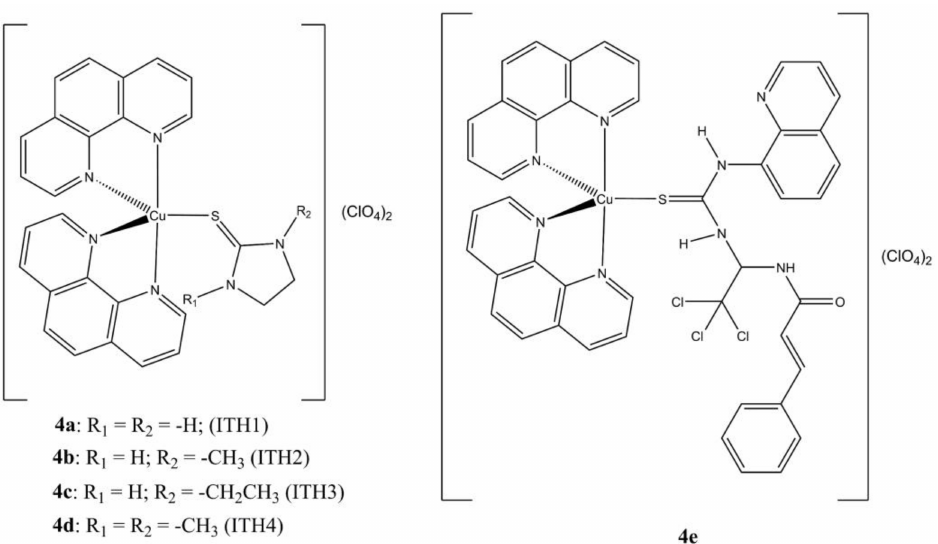
Figure 4. Structures of the [Cu(phen) 2 (ITHn)](ClO 4 ) 2 ( a – d ) and [Cu(phen) 2 (SAL)](ClO 4 ) 2 ( e )